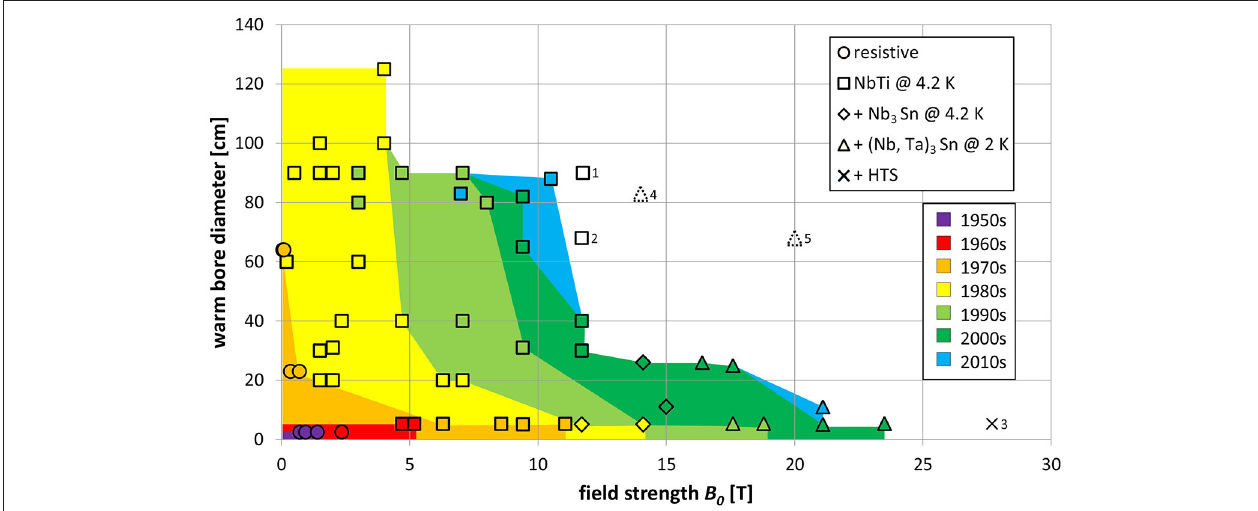
FIGURE 2 | Dependence of magnetic flux density (T) and bore size (cm) with color coding for the decade when the respective system was introduced. The shapes of the symbols represent the materials used for the magnet, as indicated in the legend. Magnets that have been successfully deployed in the field are shown with colored symbols. Symbols without color represent systems that have been installed, but are not yet fully functional (solid lines) or design studies (dotted lines). Details for these planned systems: (1) 11.75 T whole-body system CEA-Iseult, France, (2) 11.7 T head system, NIH, USA, (3) 28.2 T vertical bore system Garching, Germany, (4) Design study for 14 T whole-body system Heidelberg, Germany, (5) Design study for 20 T head system. Data and references for all data points are given in the Supplementary Materials. Fundamental limits due to the material are easily noticeable: in the lower left corner (i.e., low field strengths and small magnet bores) resistive magnets (copper wire) are clustered, with the superconducting magnets above (i.e., larger bores) and to the right (higher fields). Starting from used in addition to Nb-Ti; from 15 T, (Nb,Ta) 3 Sn is added. For the 28.2 T system, high-temperature superconductor is ∼